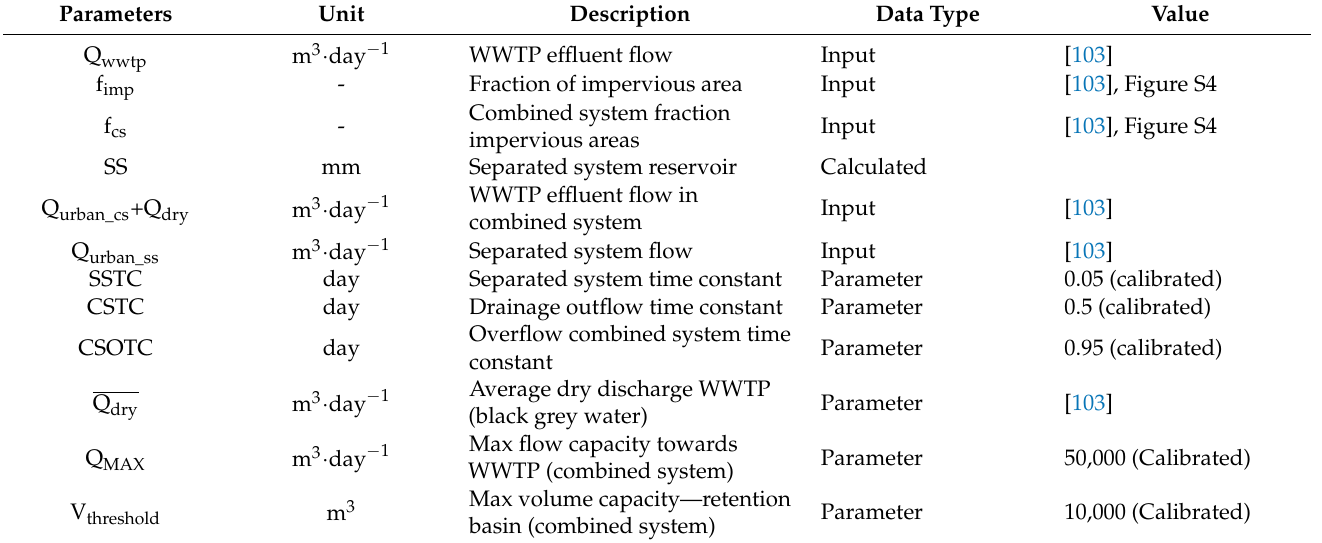
Table A3. Hydrology—urban component.